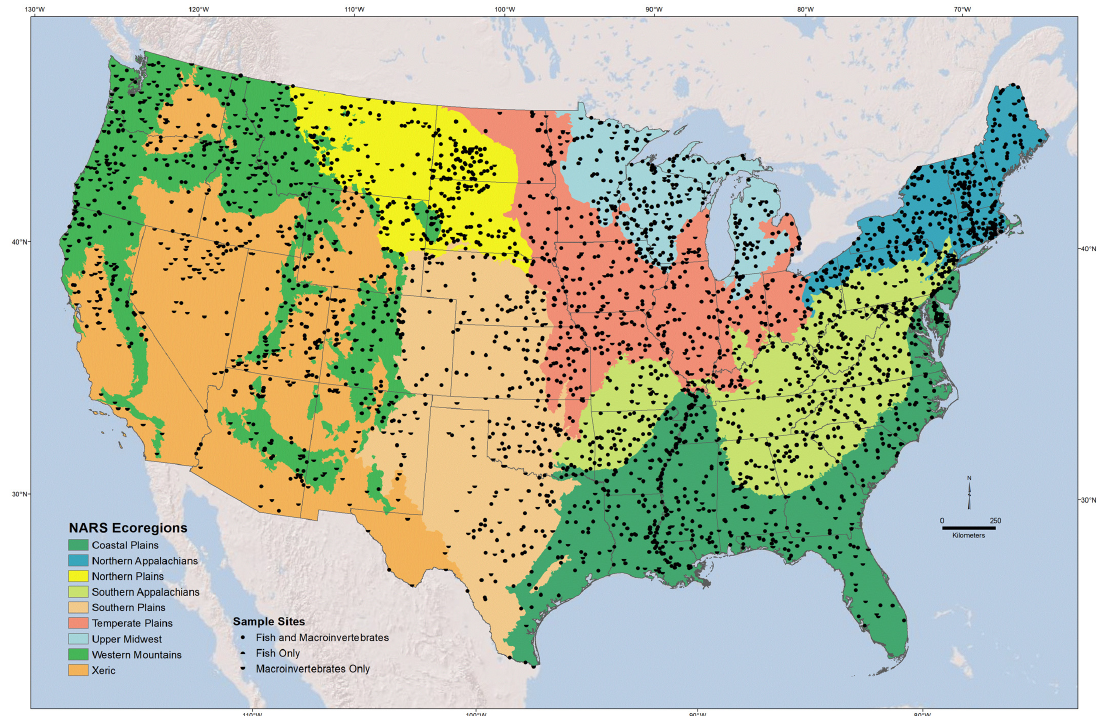
Figure 1. Locations of the NRSA sample sites and the nine aggregate ecoregions used for pattern analysis (from USEPA 2020).